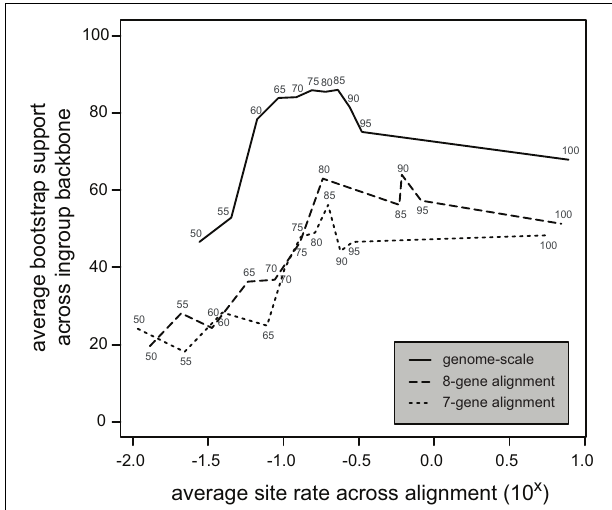
FIGURE 4 | Bootstrap support as a function of fast site removal. Numbers along the lines indicate the percentage of sites remaining in the site-stripped alignments. The average rate across the remaining sites is on the x-axis and the bootstrap support along the backbone of the core Chlorophyta relationships on the y-axis. The patterns show an increase of bootstrap support with initial fast site removal (from 100% at right hand side to intermediate percentages in center of graph) followed by a steep decrease of bootstrap support with further site removal (toward left-hand side of graph). Patterns for the bigger genome-scale alignment are smoother than those for 7-gene and 8-gene alignments. Overall bootstrap support (across different alignments) peaks at rates between 10 − 1 . 0 and 10 − 0 . 5 . Note that rates are given along the x-axis are not absolute; they were calculated using a guide tree with a root age of